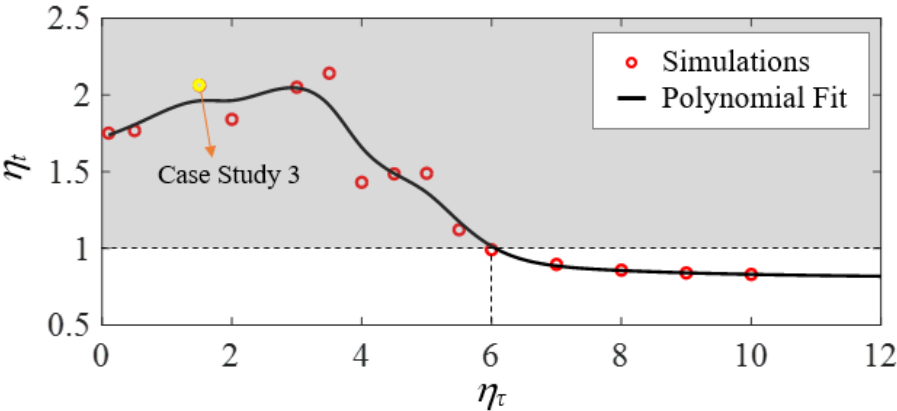
Figure 12. The ratio of total time ( η t ) as a function of the normalized inertial response time of the vehicle ( η τ ) for τ m = τ w is shown by performing many simulations (circular markers) corresponding to different values of η τ , and by performing a polynomial fit (black line) demarking case studies in which FTC uses less time than BBC (grey shaded